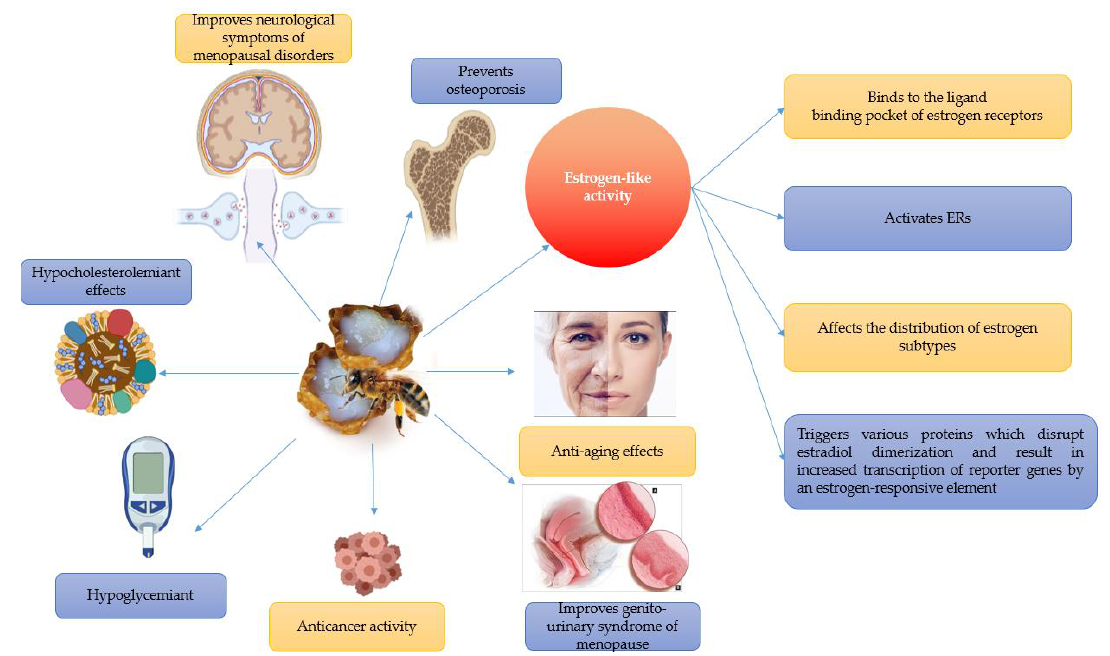
Figure 3. Royal jelly’s beneficial effects in relieving menopause symptoms and aging-related